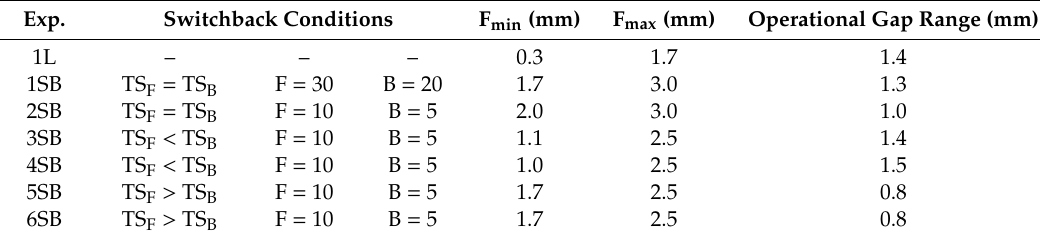
Table 5. Summary of the outputs of the experiments, as planned in Table